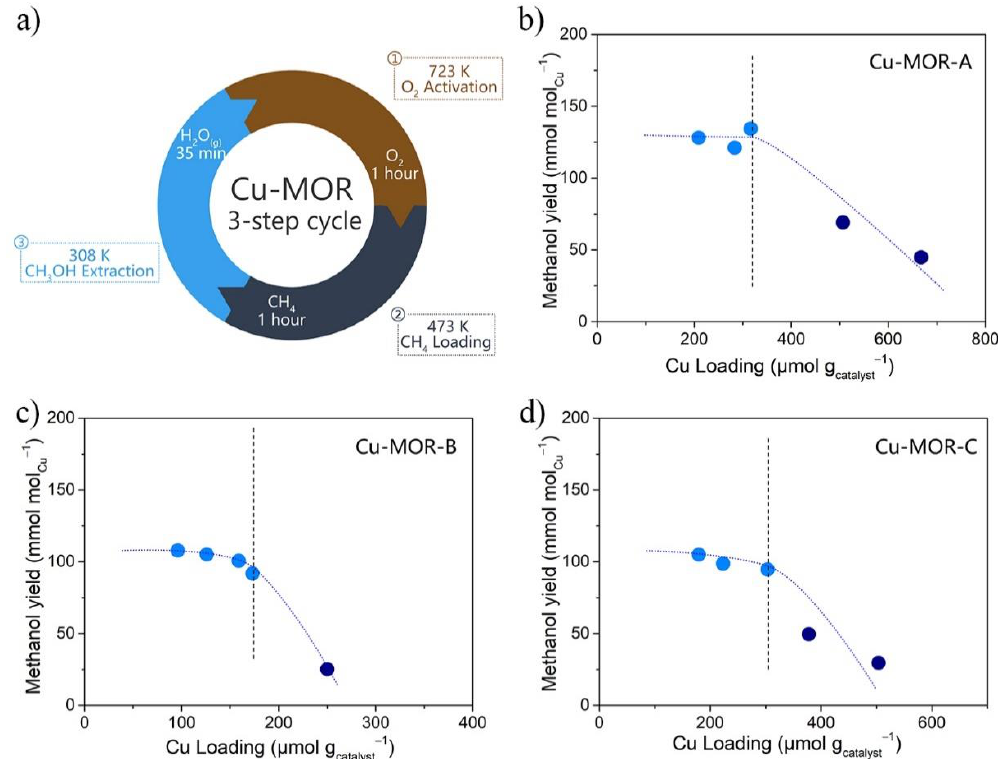
Figure 2. ( a ) The cyclic process of the methane-to-methanol reaction on Cu-MOR catalysts and the methanol yield (normalized by the exchanged Cu amount) as a function of Cu loading for ( b ) Cu-MOR-A, ( c ) Cu-MOR-B, and ( d ) Cu-MOR-C.